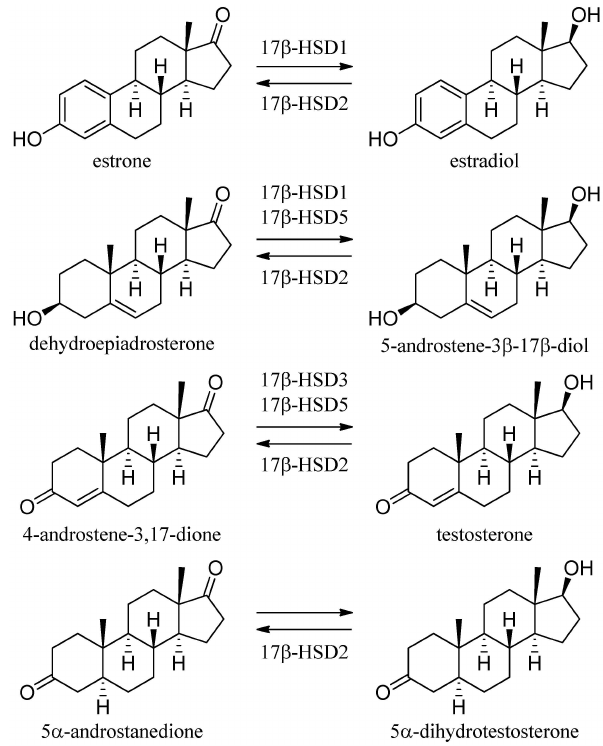
Figure 11. 17 β -HSDs involved in sex steroid metabolism.